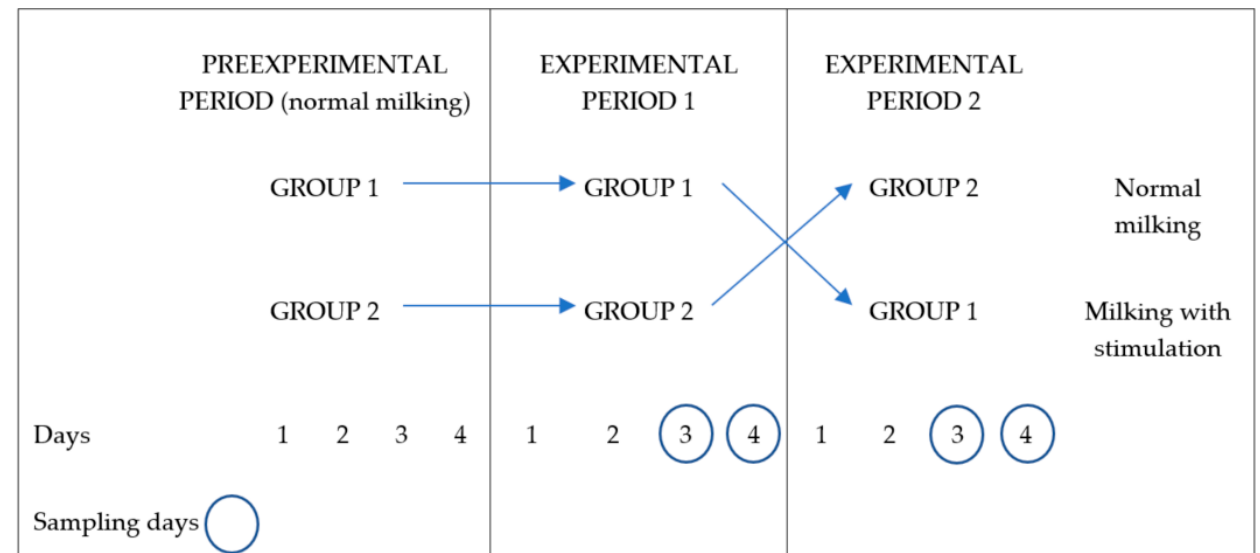
Figure 1. Schedule of each of the three experiments developed at the onset of lactation, at mid-lactation, and at the end of lactation according to the type of milking and the period within each experiment.